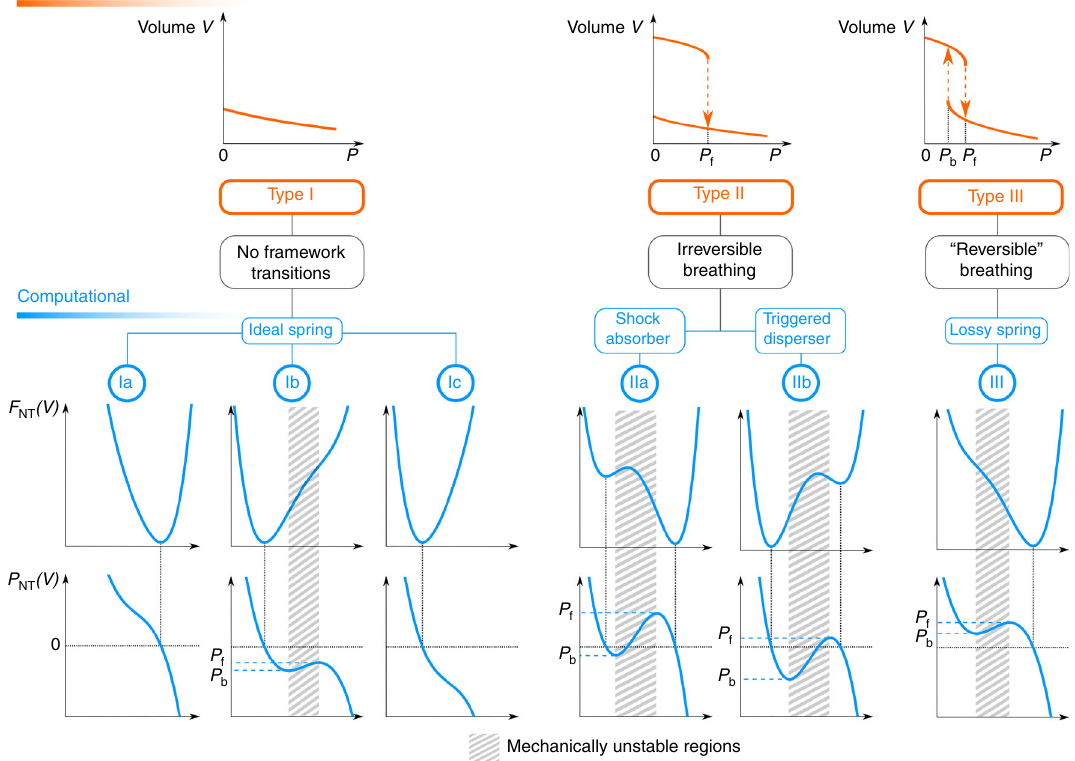
Fig. 3 Comparison of experimental response with corresponding hypothetical free energy. Top panel: iIllustration of the possible experimental responses of a material upon exerting a positive mechanical pressure 17 – 21 . Bottom panel: hypothetical Helmholtz free energy F NT ( V ) and mechanical equation of state P V ), with N the number of particles and T the temperature, in terms of the volume. Shaded areas correspond to mechanically unstable NT (